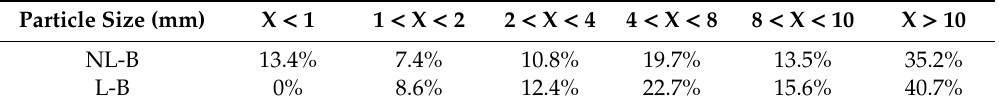
Table 1. Particle size distribution of non-leached biomass (NL-B) and leached biomass (L-B) samples. Particle Size (mm)